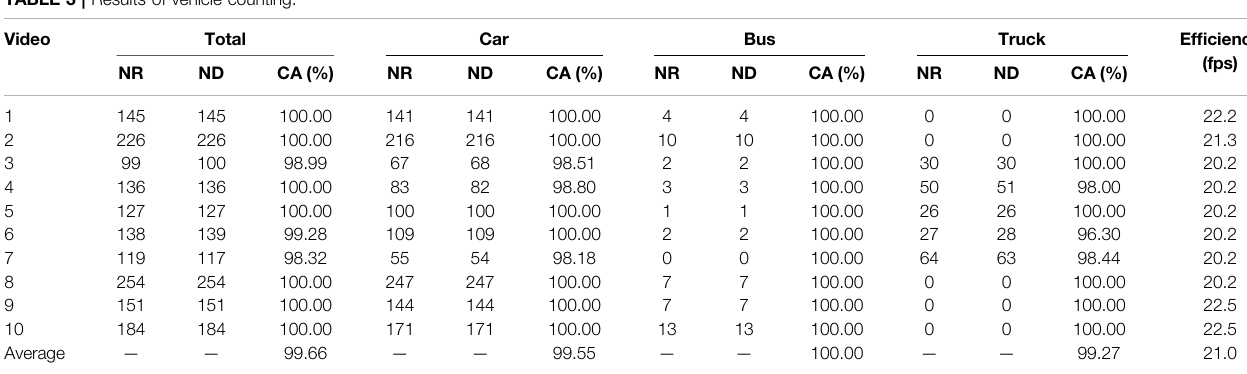
TABLE 3 | Results of vehicle counting.